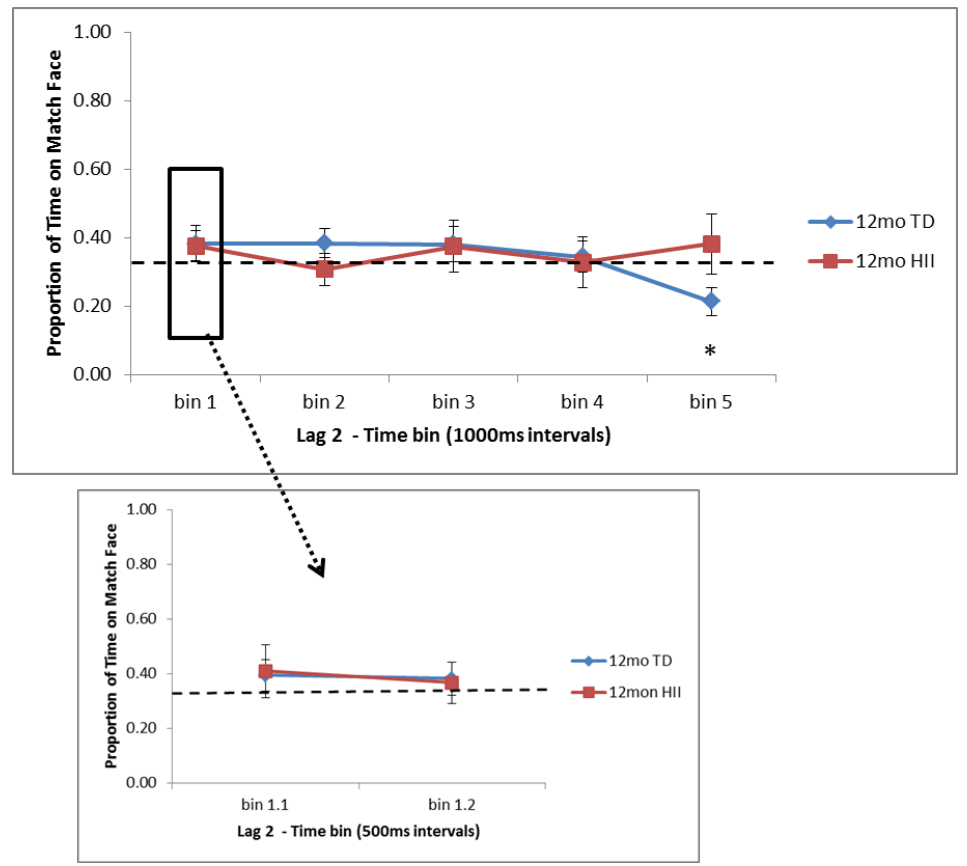
Figure 4. Proportion of time fixating the matching face for Lag 2 trials for the five 1000 ms time bins (bins 1–5) and the two 500 ms bins in the first 1000 ms (bins 1.1 and 1.2) for 12-month-old typically developing infants (TD) and hypoxic–ischemic injured infants (HII). Looking to the match face was significantly lower than expected by chance for 12-month TD infants in bin 5 (4000–5000 ms). Chance is illustrated with a dashed line; error bars indicate the standard error of the mean. * p < 0.05.